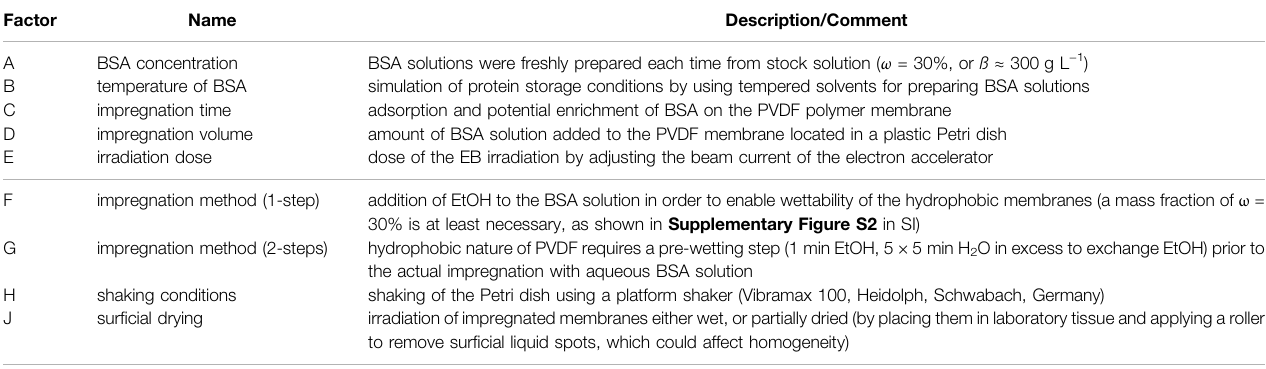
TABLE 1 | Investigated nine process factors for the EB-based graft immobilization of BSA on PVDF.